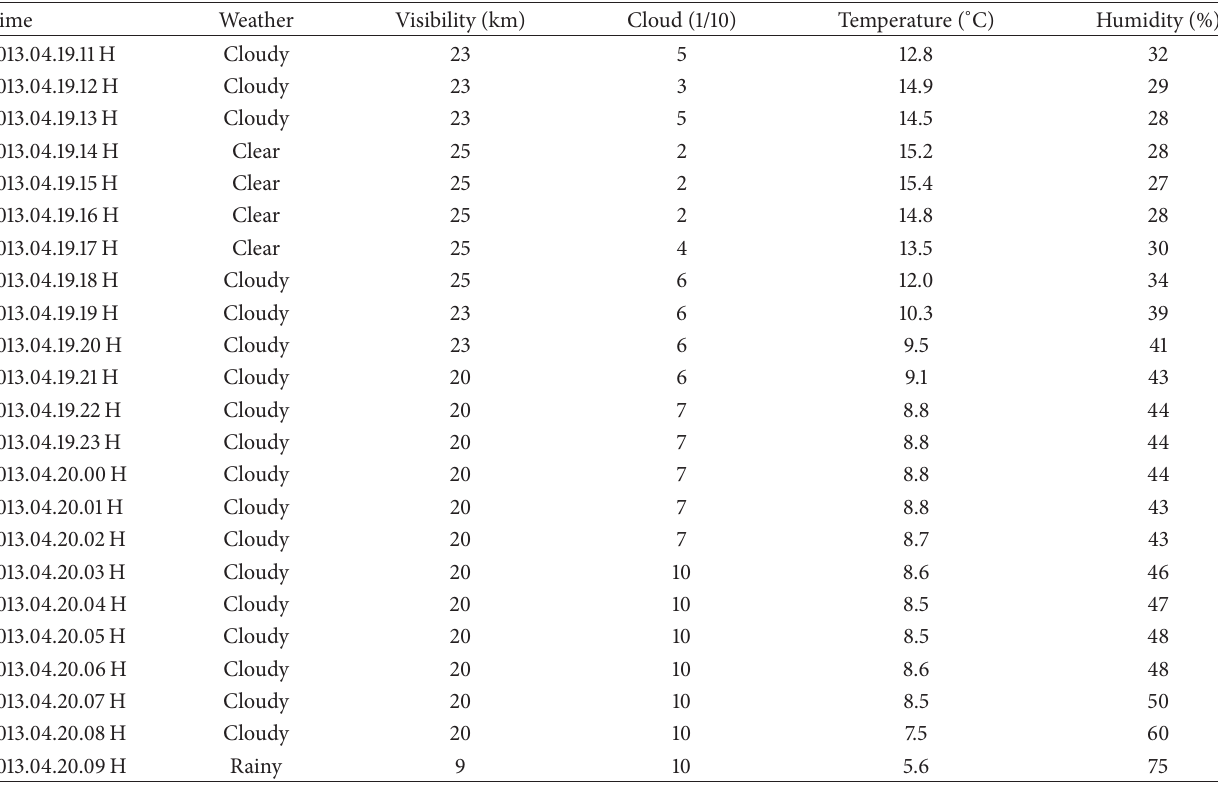
Table 3: Measured meteorological data of the recording place (spring).